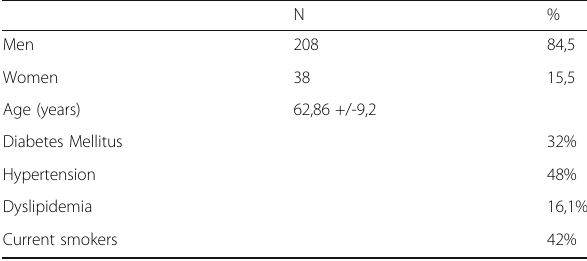
Table 1 (abstract 000532). Baseline